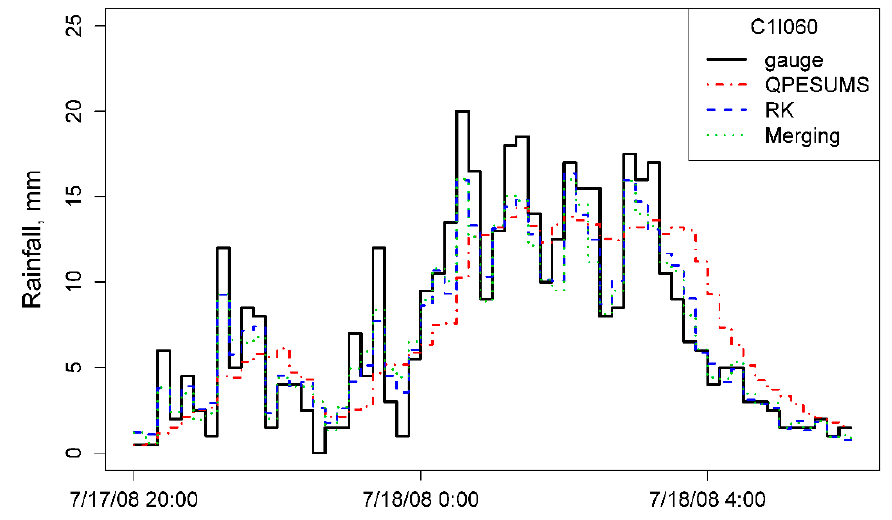
Figure 6. Hyetographs at station C1I060 showing the complete time variations in the rainfall data from RK (adjusted), merging (adjusted), QPESUMS (unadjusted), and gauges for the event of Typhoon Kalmaegi.